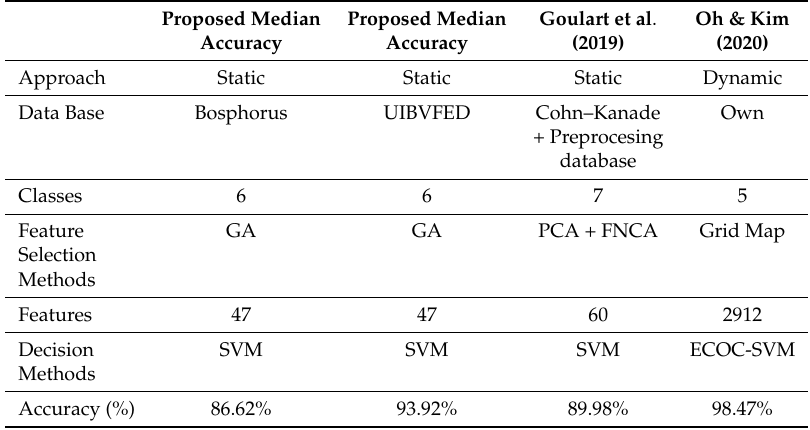
Table 20. Comparison with other handcrafted feature method on different